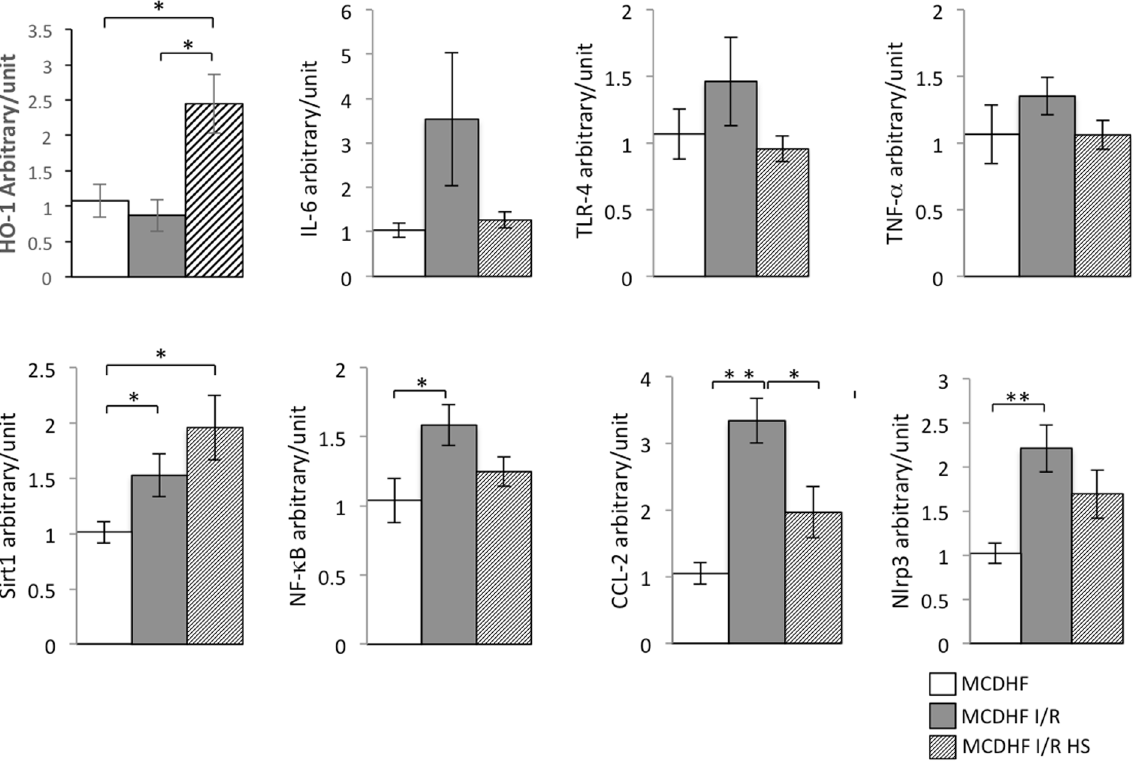
Figure 2. Hydrogen saline decreased the expression of inflammatory cytokines and the biochemical parameters, but increased the Sirt1 and HO-1 expression in the steatotic liver under I/R injury. The mRNA expression of TNF- α , IL-6, NF- κ B, TLR-4, CCL-2, Nlrp3, Sirt1, and HO-1 in different groups. (Data are representative of 5 to 7 animals for each group). Data are expressed as the means ± SEM; * p < 0.05, ** p <